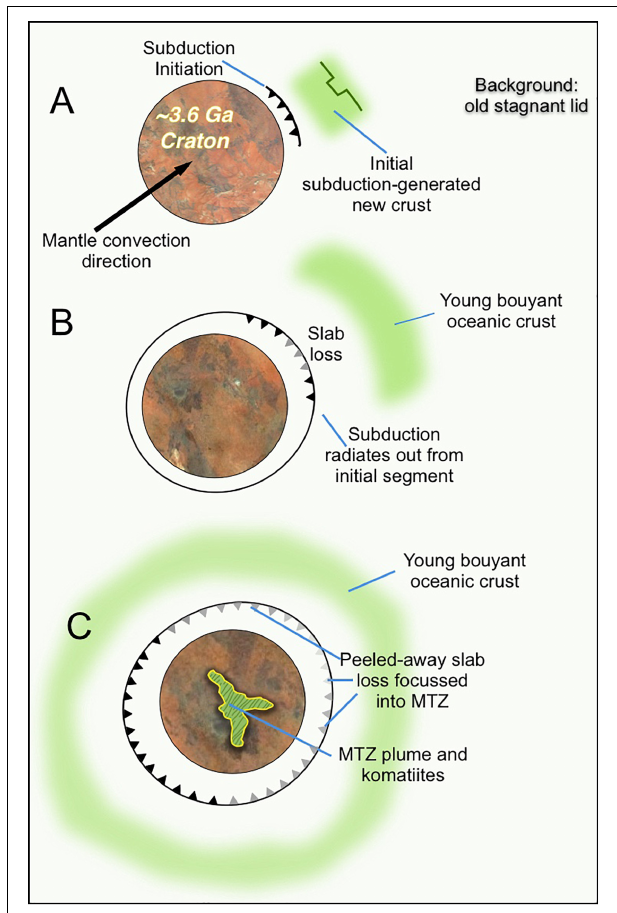
FIGURE 7 | A linked subduction – plume model for early Paleoarchean evolution of the Pilbara and other cratons. It is assumed that subduction initiation is feasible but does not lead to self-sustaining subduction or a set of global plates. (A) Mantle convection drives the idealized circular proto-craton (as used in many numerical models), which is thicker than surrounding lid, in a preferred direction that results in focused stress in the opposing stagnant lid. Local subduction initiates, which leads to formation of some new lid crust. (B) Slab loss occurs rapidly but subduction initiation propagates around the edge of the craton. (C) Focused slab loss delivers abundant crust to the MTZ, where material is displaced upwards resulting in a komatiite-generating damp plume. The craton is surrounded by newly generated crust that must cool down before another episode of subduction and plume generation